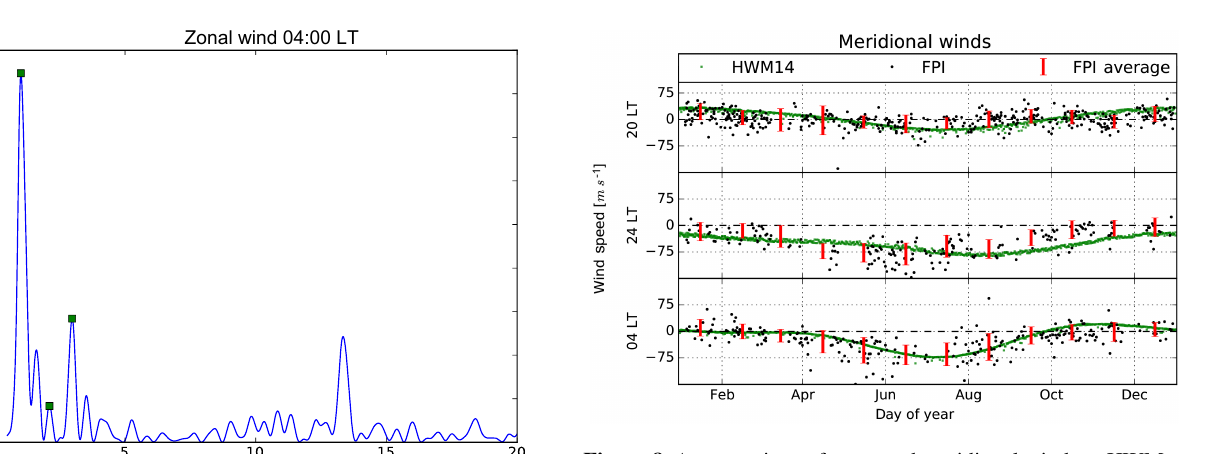
Figure 8. A comparison of measured meridional winds to HWM at fixed local times of 20:00, 24:00, and 04:00. The black dots repre- sent a binned measurement, the red bars represent monthly averaged FPI estimate, and the green dots represent the HWM14 airglow- weighed estimate. Positive values are northward.